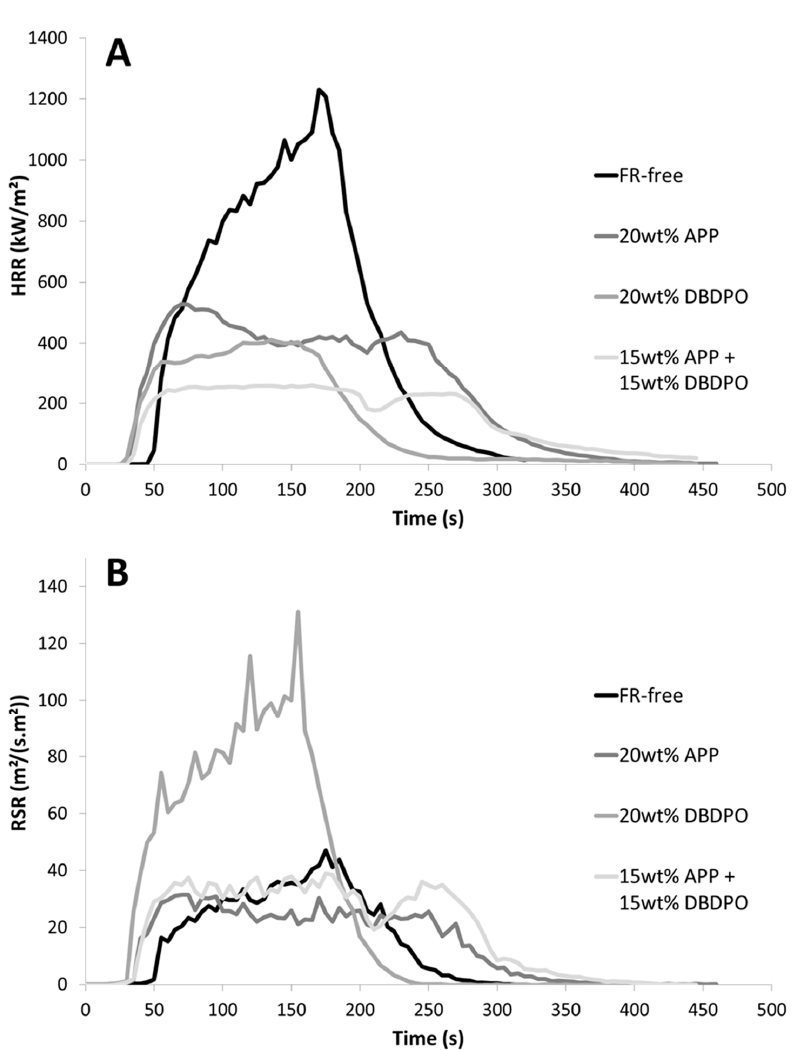
Figure 6. ( A )/HRR versus time in cone calorimeter (50 kW/m 2 ) for ABS filled with APP and/or DBDPO. ( B )/RSR versus time in cone calorimeter (50 kW/m 2 ) for ABS filled with APP and/or DBDPO